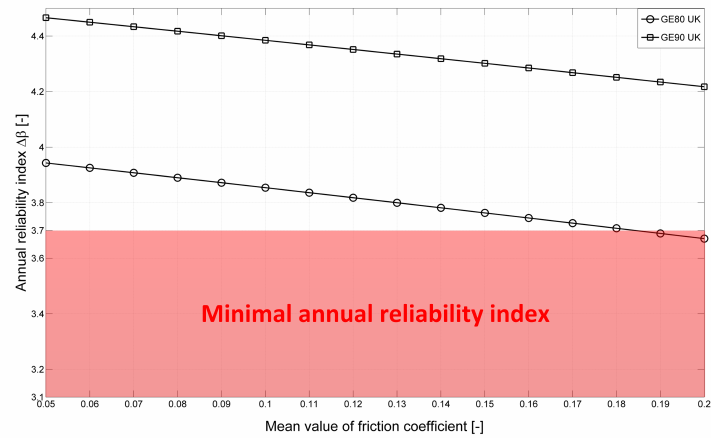
Figure 13. Annual reliability index for different bearings dependent on the mean friction coefficient µ . The mean value crack size a is set equal to 0.15 mm; the COV of the expected friction coefficient remains constant at 0.15 and the COV value of X WL equal to